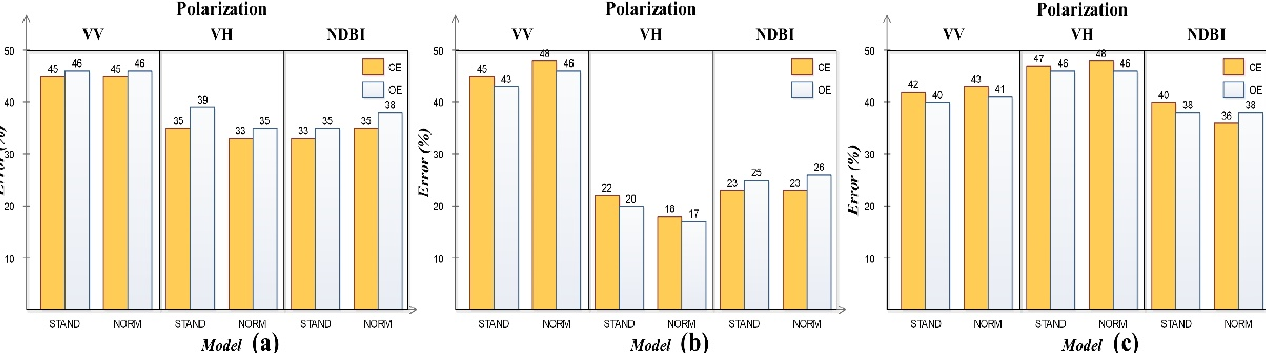
Figure 6. Omission and commission errors (average through classes): ( a ) dry conditions, ( b ) wet conditions, and ( c ) mean conditions. Table 2. Validation results for severity estimates under different environmental conditions obtained for the VH polariza- tion. Environmental Condition